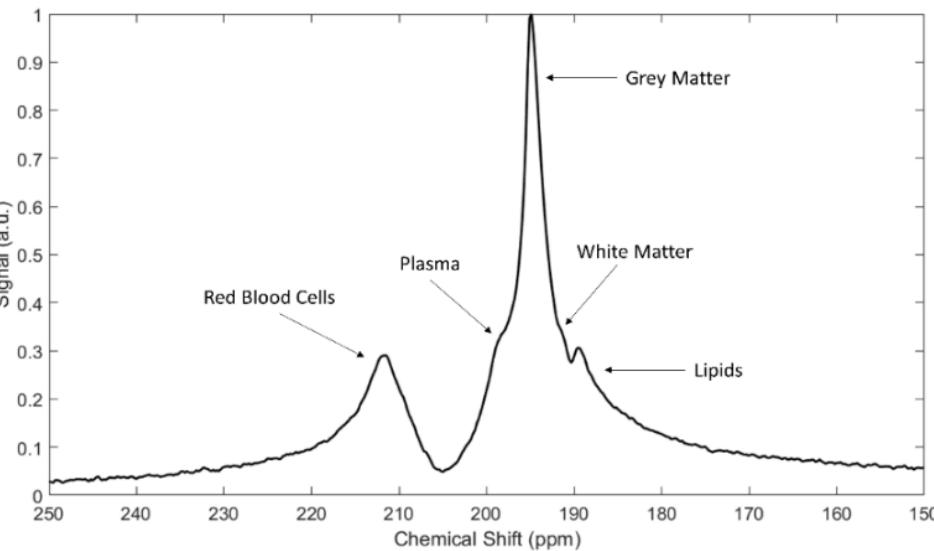
Figure 27. Representative HXe spectrum acquired in the rat brain. Reprinted with permission from Friedlander, et al. ( Magn Reson Med 2021, ref. [106]).